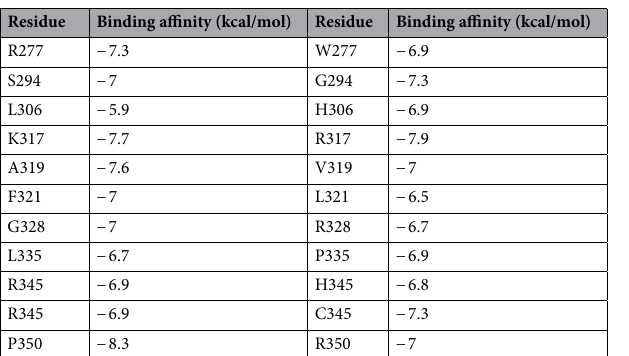
Table 3. Docking results of RASSF5 with